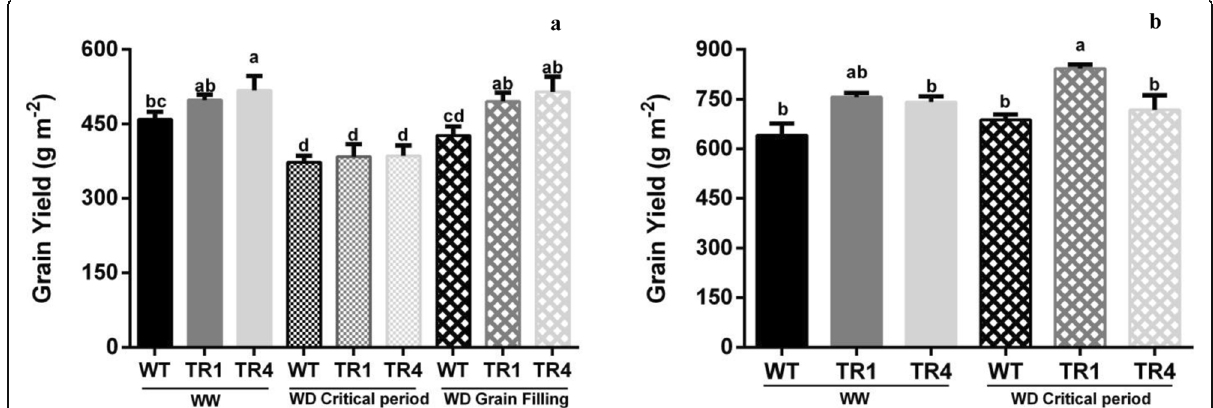
Fig. 7 Grain yield for the three genotypes (WT, TR1, and TR4) grown under field conditions. Grain yield obtained in well-watered (WW) and water-deficit conditions applied during the critical period (WD CP ) and grain filling (WD GF ) in a San Juan (EXP4) and b Bordenave (EXP5). Mean ± S.D., n = 3 for each data point. Means sharing the same letters in columns do not differ ( p <